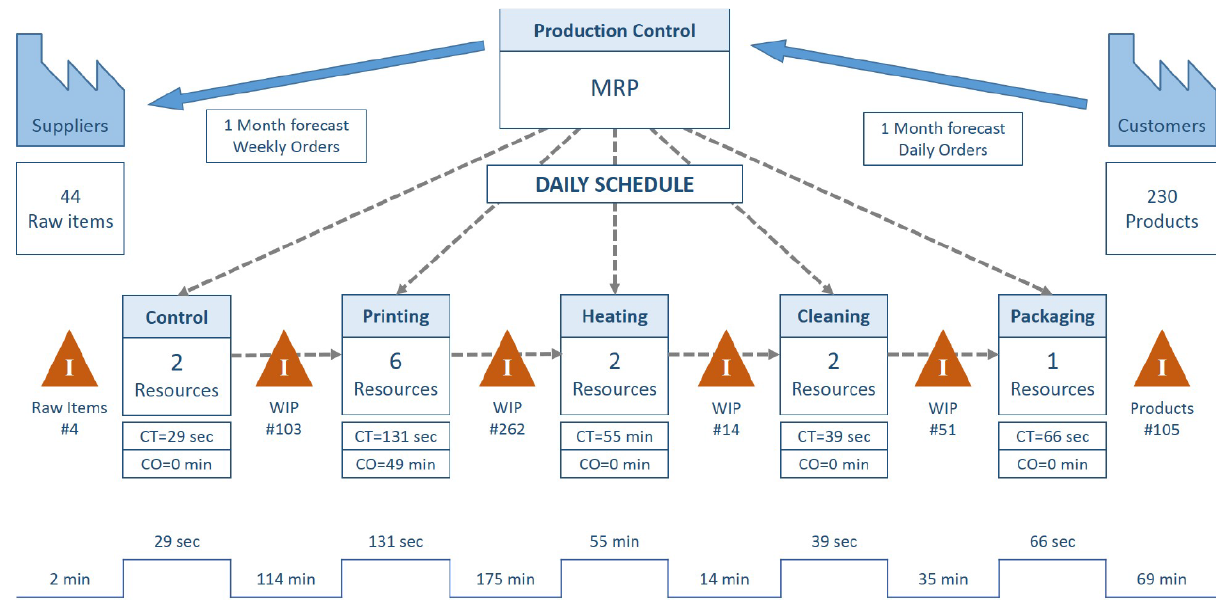
Figure 5. VSM Design Point: #3 JITds Map